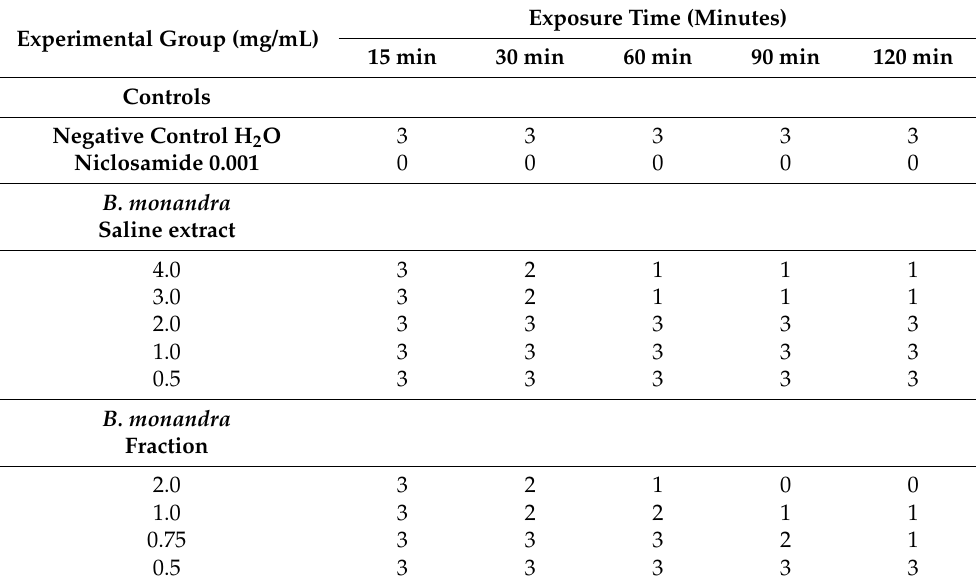
Table 3. Scores of cercariae exposed to saline extract and fraction of B. monandra in relation to exposure time. Exposure Time (Minutes) Experimental Group (mg/mL) 15 min Controls Negative Control H 2 O Niclosamide 0.001